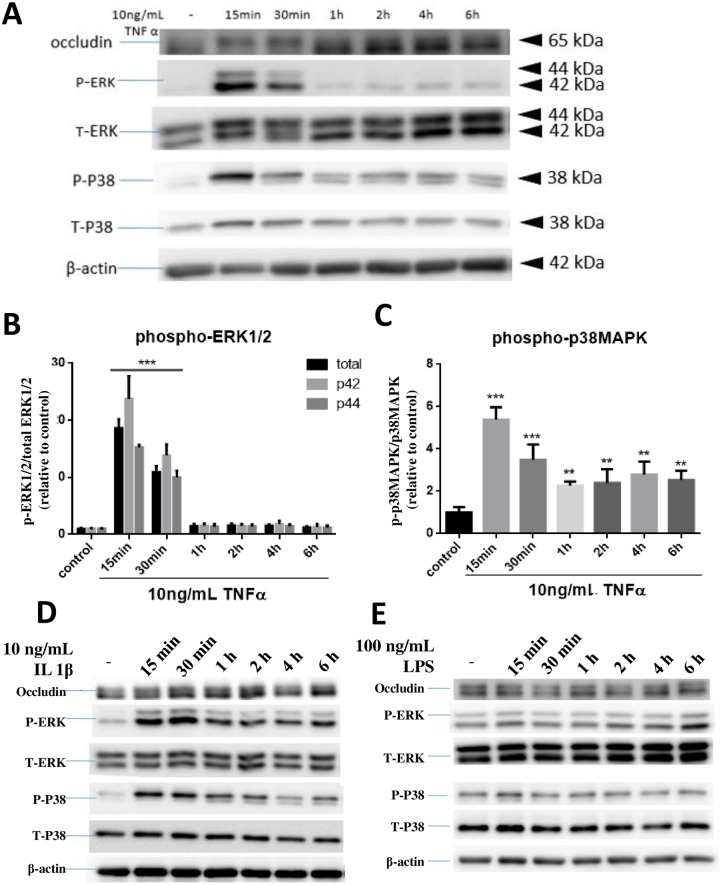
Effects of TNFα, IL-1β and LPS on p-ERK1/2 and p-p38MAPK expression in hCMEC/D3 cells.Cells were treated with or without TNFα (A, B, C), IL-1β (D) and LPS (E) for 15, 30 min and 1, 2, 4, 6 hours. Cell lysates were collected and phospho-ERK1/2 (P- ERK), total ERK1/2 (T-ERK), phospho-p38MAPK (P-P38), total p38MAPK (T-P38) and β-actin expression pattern were analyzed by immunoblotting assay. Quantification of phospho-proteins was determined through assay of PIphospho/PItotal/PIβ-actin and then normalized to control. Results of (B) and (C) are mean ± SD from 4 or more experiments and data are analyzed by one-way ANOVA followed by Bonferroni post-tests **P<0.01, ***P<0.001 compared with no treatment control). Results of (D) and (E) are representation of two repeated experiments.